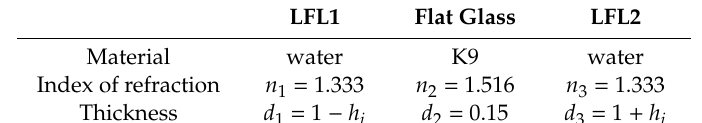
Table 1. The optical parameters of the UTL.